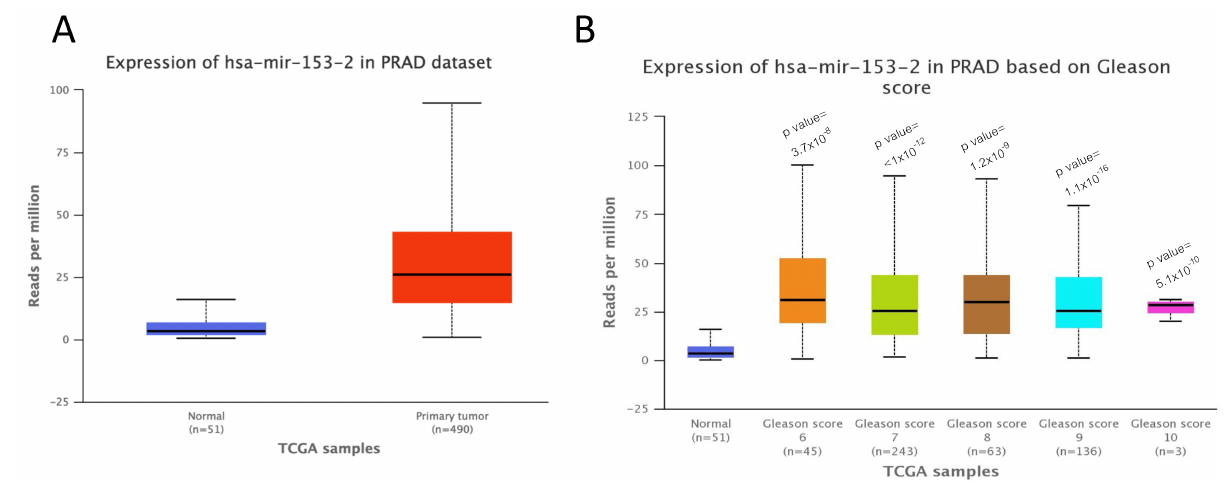
Figure 2. miR-153 overexpression in prostate adenocarcinoma is associated with higher Glea- son score and poor prognosis. ( A ). UALCAN analysis of the expression levels of miR-153 in prostate adenocarcinoma (PRAD) primary tumors ( n = 490) compared to normal samples ( n = 51) ( p value = 1.62 × 10 − 12 ). ( B ). Expression of miR-153 in different samples from TCGA, based on their Gleason score ( p values have been calculated between PC and normal tissue